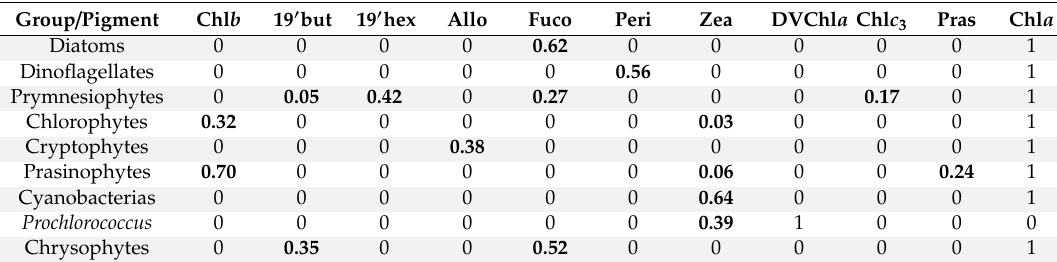
table by a random function [44]. The average of the best six output matrices (i.e., those with the lowest residual root mean square errors or RMSE) was taken as the optimized result (Tables S3 and S4 in Supplementary Material). Table 3. Initial pigment ratios used in CHEMTAX